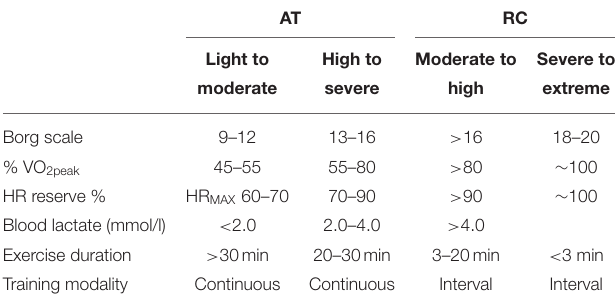
TABLE 1 | Exercise intensity